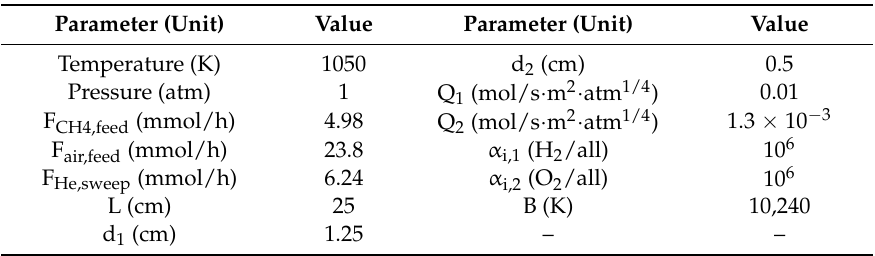
Table 1. Base case simulation design and process